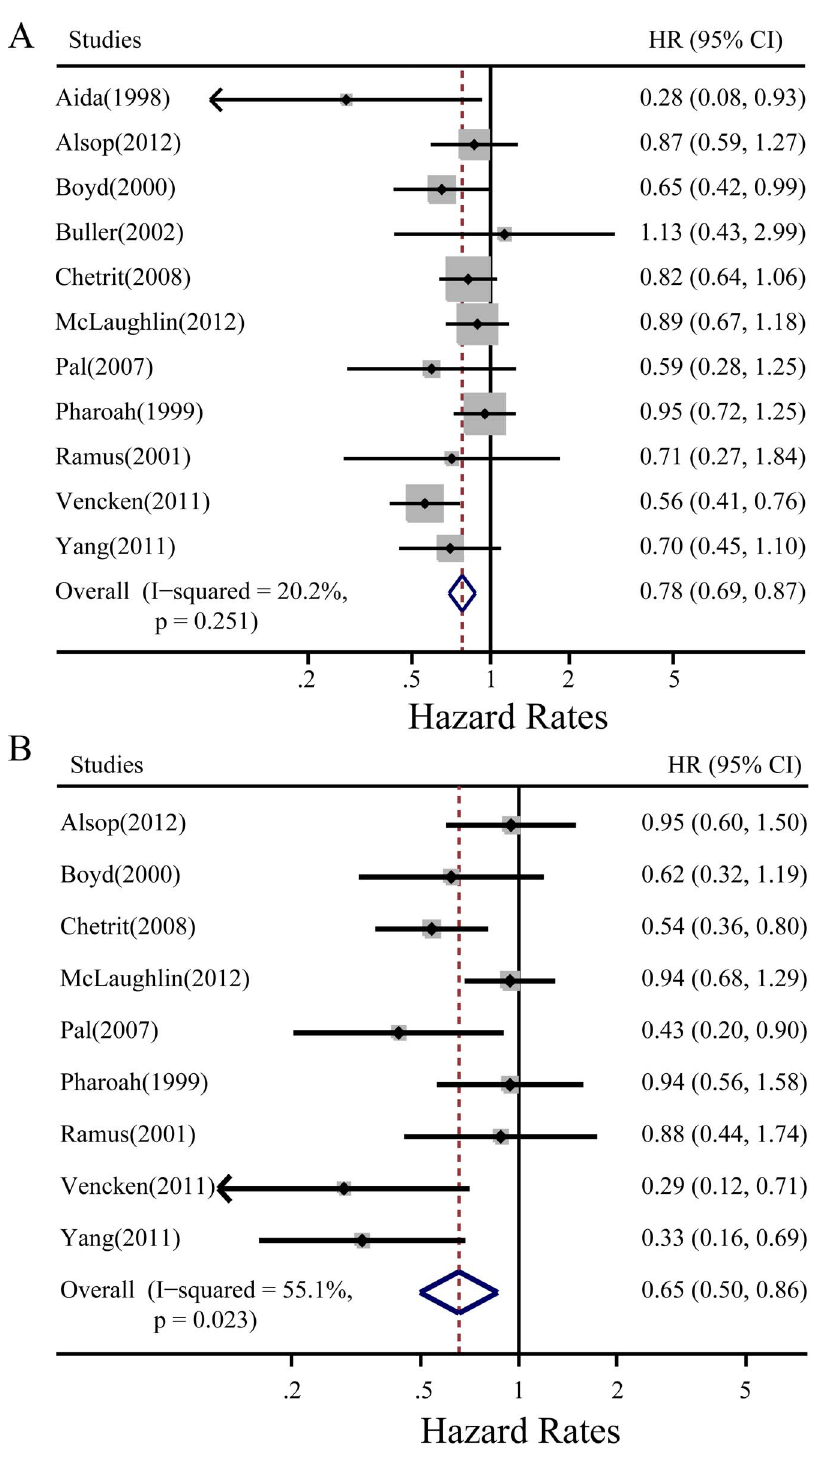
Figure 3. Subgroup meta-analysis of summary hazard ratios (HRs) and 95% confidence intervals (CIs) of ovarian cancer OS for different BRCA mutation statuses. A: BRCA1 mutation. B: BRCA2 mutation. Horizontal lines represent 95% CIs; diamonds represent summary estimates with corresponding 95% CIs. Test for heterogeneity: A: P =.251, I 2 =20.2%, a fixed-effects model was used; B: P =.023, I 2 =55.1%, a random-effects model was used. doi:10.1371/journal.pone.0095285.g003 neity of all subgroups were not significant. BRCA dysfunction subgroup analyses according to different BRCA statuses, status was associated with a better PFS in ovarian cancer, with BRCA1/2 mutation and low BRCA1 expression by IHC were HR = 0.69 (95% CI: 0.63–0.76, fixed-effect model). In the statistically significant predictors for longer PFS (HR= 0.65, 95%